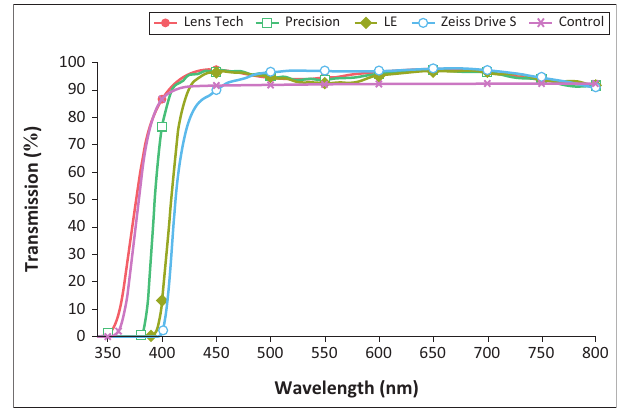
FIGURE 3: Transmission curves for four lenses with antireflection coatings. Lens Tech (red), Lenz Xpress (green), Precision (green), Zeiss Drive S (blue) and the control lens (magenta).